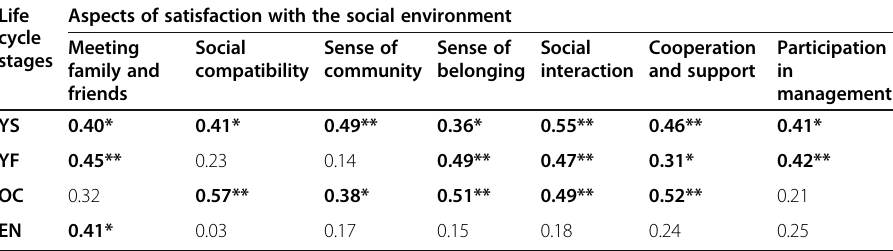
Table 13 Correlations between satisfaction with the social environment and its different aspects Life Aspects of satisfaction with the social environment cycle stages